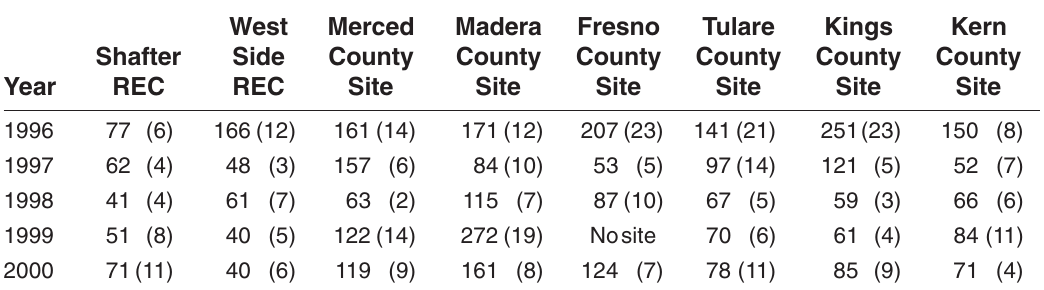
Average Postplanting (Within 7 Days Following Planting) Residual NO -N Determined on Air-Dried Samples 3